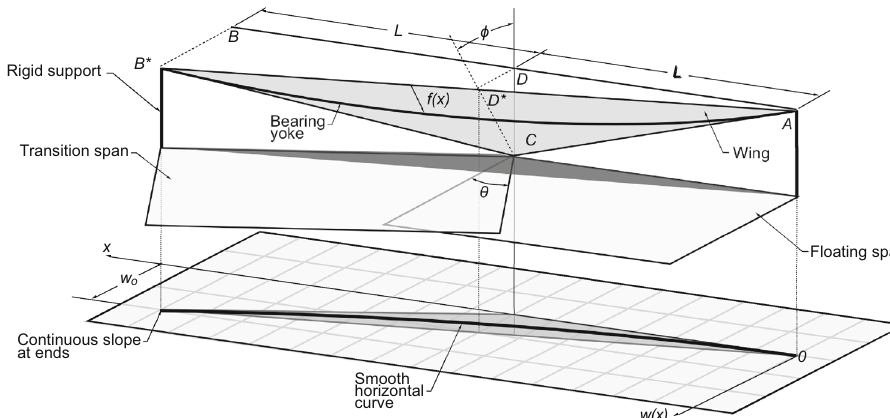
Fig. 11 Geometry for analysis